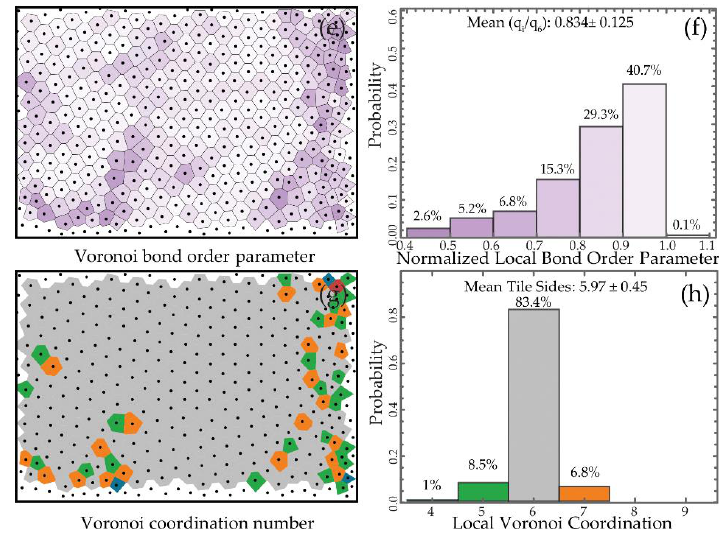
Figure A5. Spatial statistics of sedimented SiPs40. ( a ) SEM image with insert of coordination map or fast Fourier transform (FFT) showing six distinct lobes as expected for hexagonally packed systems ( b ) pair correlation function for the particle distributions (blue) and that of the matched hexatic lattice (grey). Using the average spacing (2r hex ) of a hexagonal lattice with the same number density (located at particle positions), the matched hexatic lattice is determined by randomly displacing the particles from their center with a mean distance relative to a normal probability distribution. The widths of these peaks correspond to the average mean displacement each particle has relative to this expected spacing, described by the lattice disorder parameter, σ . The nearest neighbor distance can be determined from the maximum of the first peak in the g(r) . The insert above shows the difference spectrum, which is the subtraction between the pair correlation function and the hexatic lattice. ( c ) Voronoi tessellations of the particle centroids colored by percent deviation of the expected cell area produced from hexagonal packing. ( d ) Histogram of the probabilities of various percent deviations of the Voronoi cell areas from those produced from hexagonal packing. Taking into account cells with packing of less than 15% of a perfect hexagonal lattice (three blue bars), the film shows 63.5% hexagonal packing regions. This is likely due to the disorganized region visible at the right hand side. ( e ) Voronoi tessellations of the particle centroids colored by the normalized bond order parameter. Whiter areas indicate particles that have high angular order in a hexagonal ( q 6 ) symmetry basis. ( f ) Histogram of the probabilities for various values of the bond order parameter. The extracted global bond order parameter is 0.834 q/q6 (i.e., 83% of perfect hexagonal symmetry). Expectation value for individual cells (maximum of histogram) is 90% of hexagonal symmetry ( g ) Voronoi tessellation of the particle centroids colored by the number of shared facets (coordination number). ( h ) Histogram of the probabilities for each coordination number. Over 84% of particles have six nearest neighbors, with ~8% of matched 5/7 declination